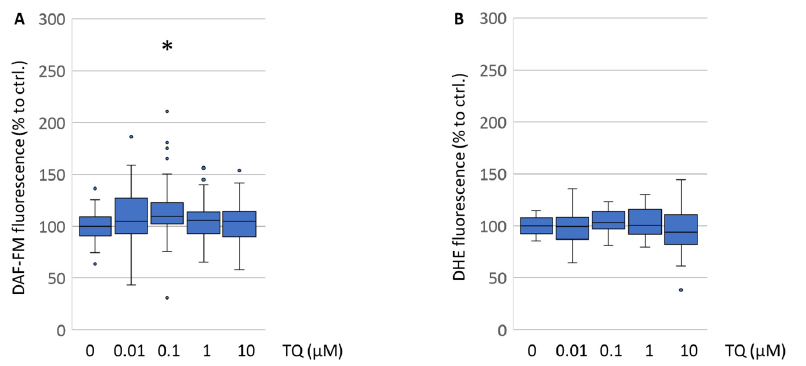
Figure 5. NO concentrations ( A ) and ROS formation ( B ) of 48 h TQ-treated primary mesencephalic cultures. Untreated control groups were set to 100%. The data represent seven independent experiments. Statistically significant differences between the TQ groups comoared to the respective controls were determined using the Kruskal–Wallis (H) test followed by the χ 2 test (* p < 0.05).